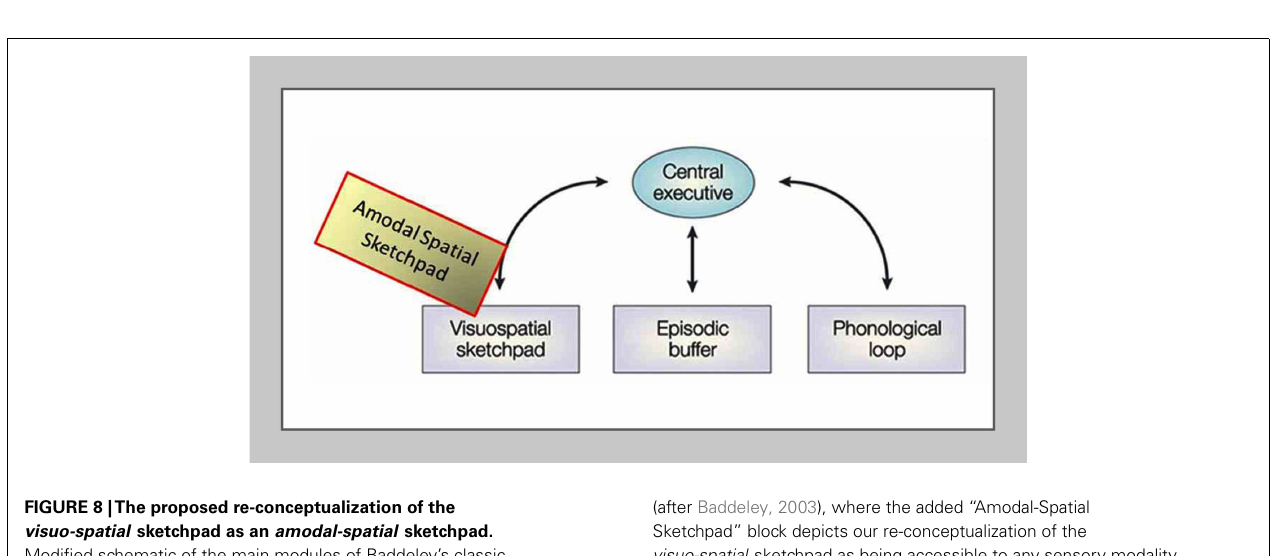
FIGURE 8 |The proposed re-conceptualization of the visuo-spatial sketchpad as an amodal-spatial sketchpad. Modified schematic of the main modules of Baddeley’s classic model of working memory including the visuo-spatial sketchpad